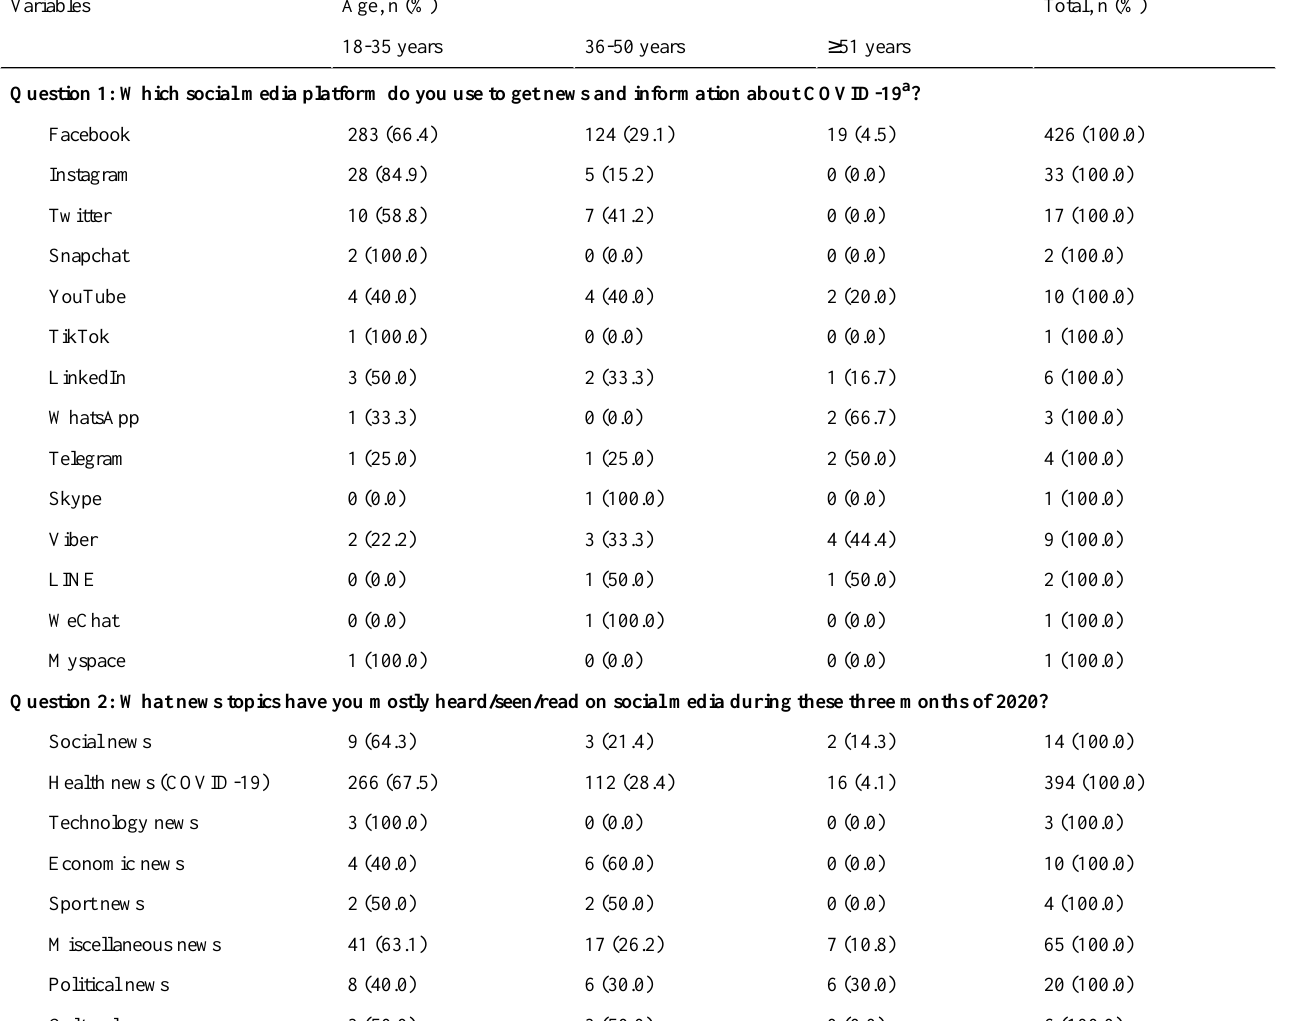
Total, n (%)Age, n (%)Variables